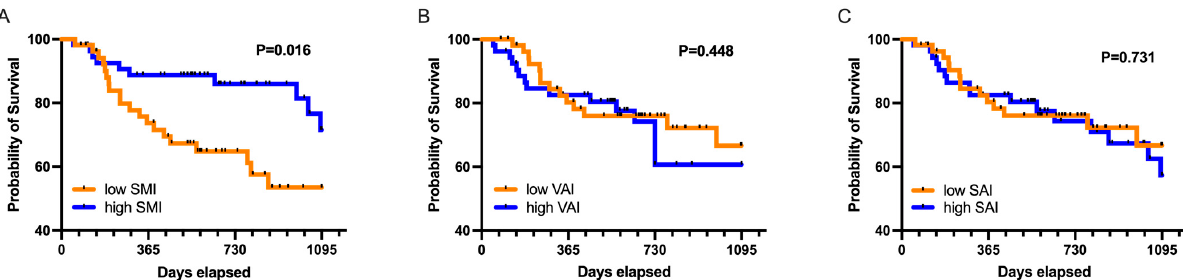
Figure 2. Kaplan–Meier curves illustrating 3-year mortality of patients with high compared to low ( A ) skeletal muscle index (SMI), ( B ) visceral adipose tissue index (VAI), and ( C ) subcutaneous adipose tissue index (SAI). Table 2. Clinical characteristics of patients with high and low skeletal muscle index (SMI). Abbrevia- tions: PD-1, programmed cell death 1 inhibitor (nivolumab or pembrolizumab), CTLA-4,